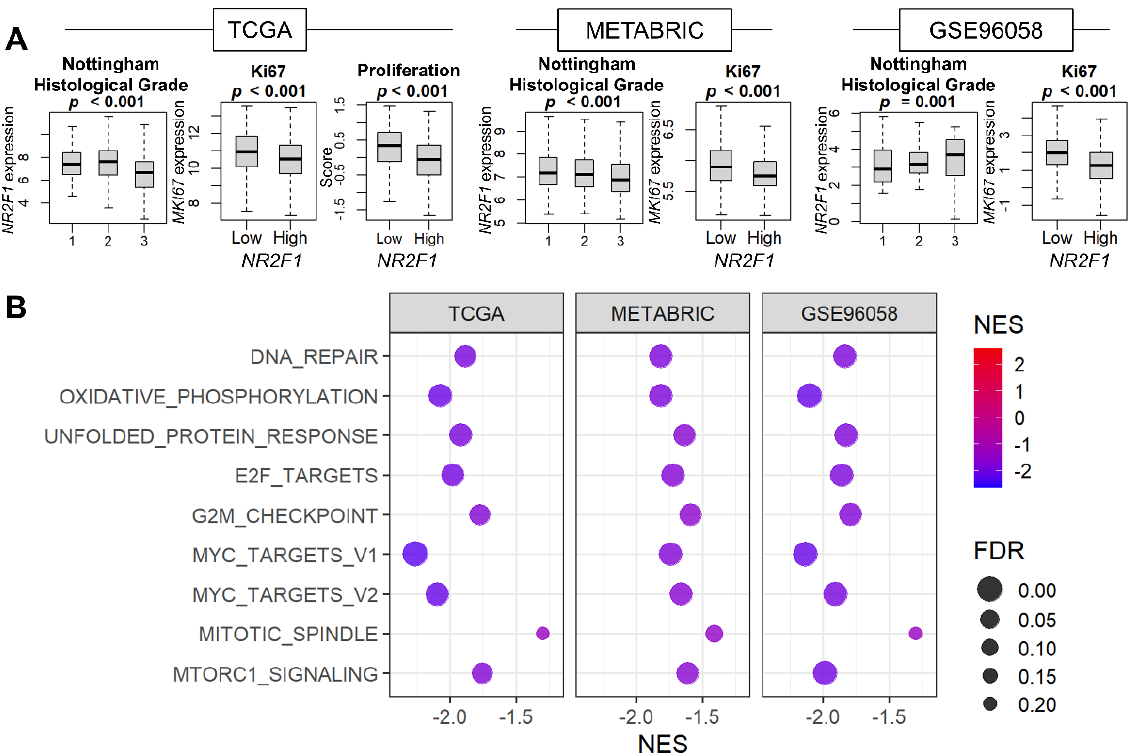
Figure 2. Association of NR2F1 expression with cell proliferation − related measurements and path- ways. ( A ) Boxplots of NR2F1 expression by Nottingham histological grade and MKi67 expression in three cohorts. Proliferation score based on NR2F1 high vs. low expression in TCGA cohort. The Kruskal–Wallis H test was used for three groups, and the Mann–Whitney U test was used for two − group comparison. ( B ) Hallmark gene sets were significantly enriched in the low NR2F1 group in all three cohorts by GSEA.